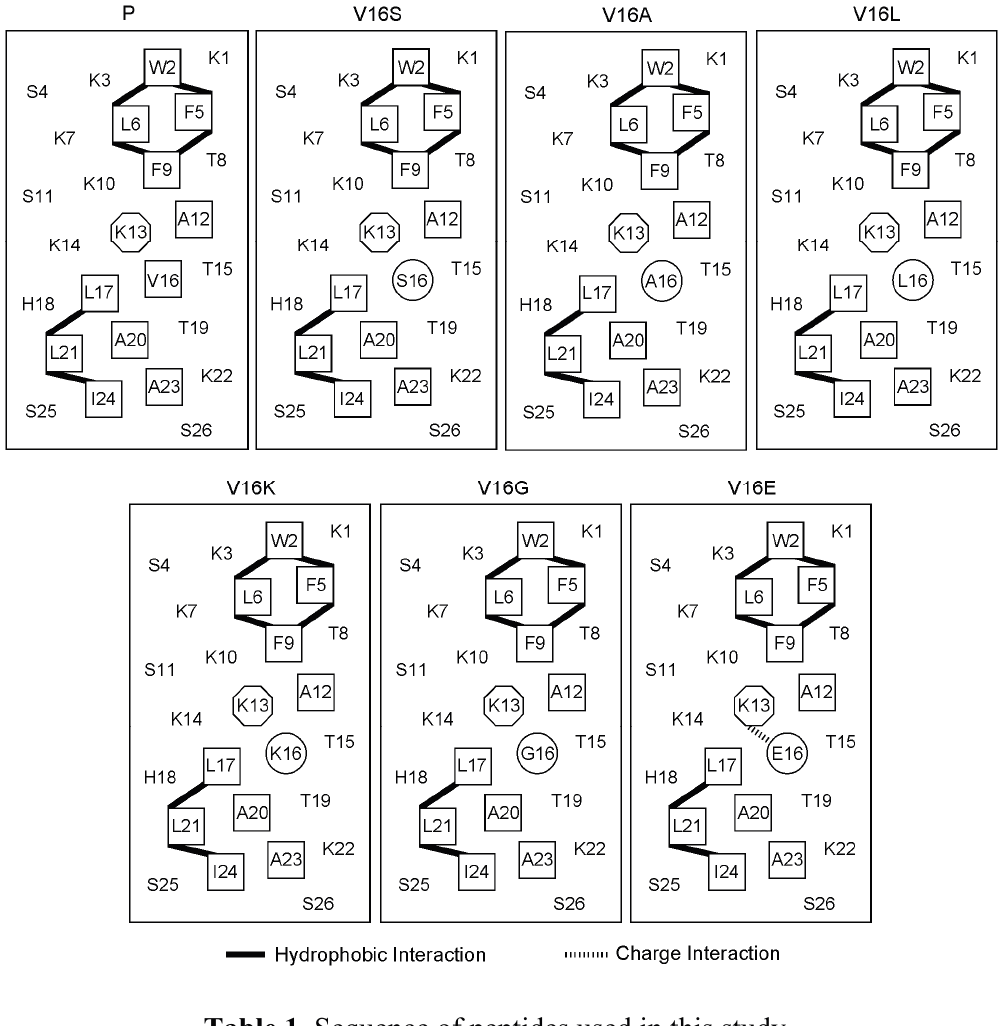
Figure 1. Helical net representation of peptides analogs. The hydrophobic amino acid residues on the non-polar faces are boxed. The substituting amino acids on the non-polar face are circled. The lysine at the position 13 on the non-polar face is in octagon. The i → i + 3 and i → i + 4 hydrophobic interactions and charge interactions are shown as black bars and hashed bars, respectively. The one-letter code is used for the amino acid residues.